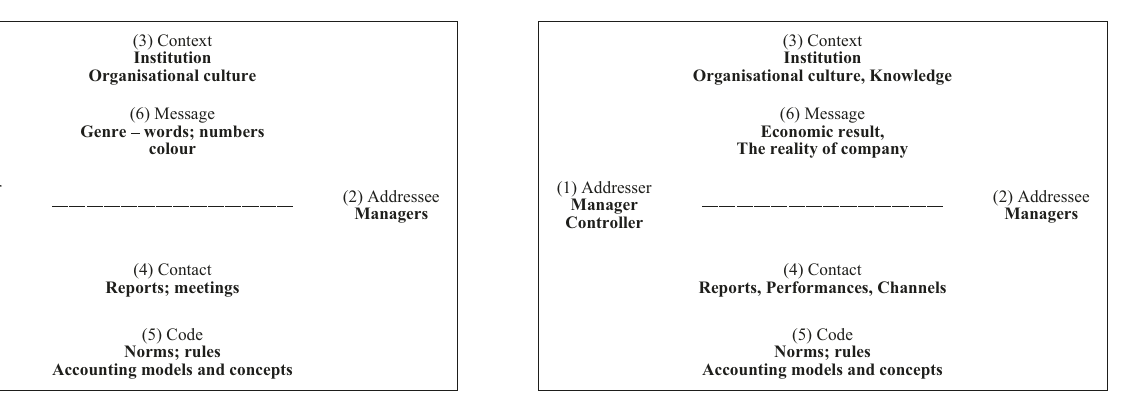
Fig. 3 Communication model in Pärl (2011). Source: Partially modi fi ed from Pärl (2011, p. 196).